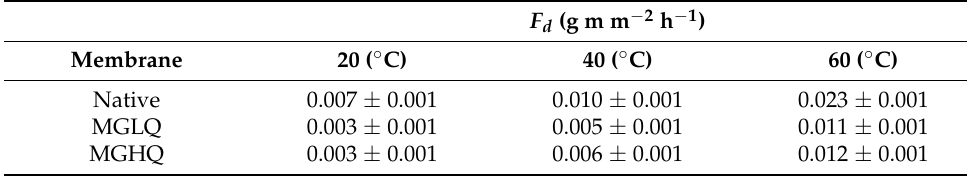
Table 5. Mass fluxes of water vapor through the self-standing bituminous membranes multiplied by membrane thickness, F d , measured at 20, 40, and 60 ◦ C and as an average of the experimental data taken in the range of 20–48 h.